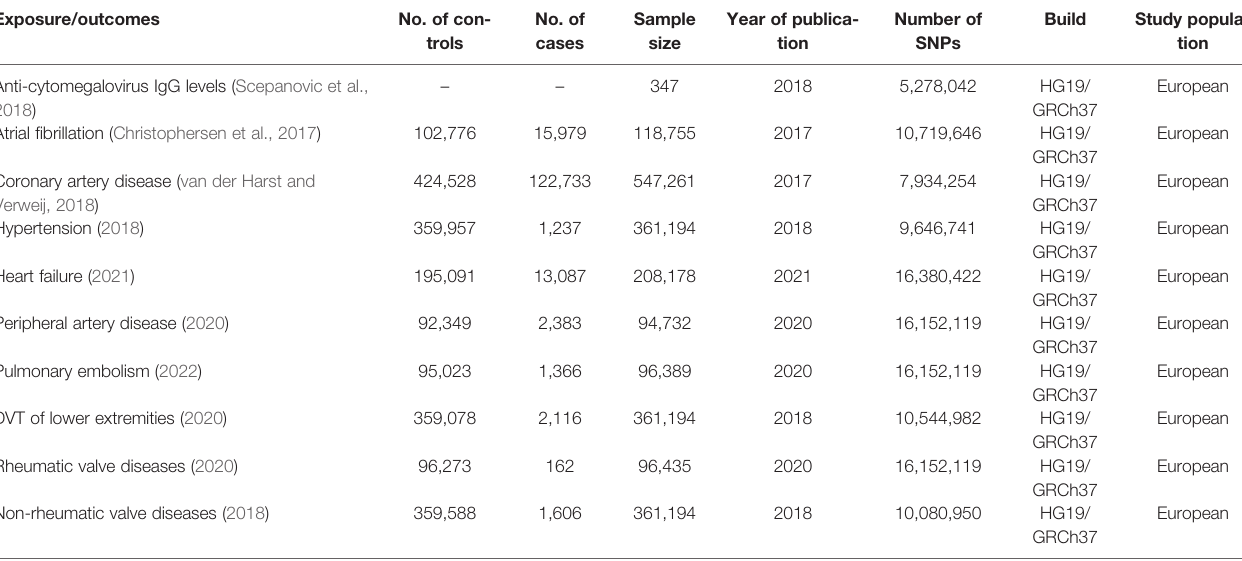
TABLE 1 | Characteristics of GWASs in anti-cytomegalovirus IgG levels and the risk of 9 cardiovascular